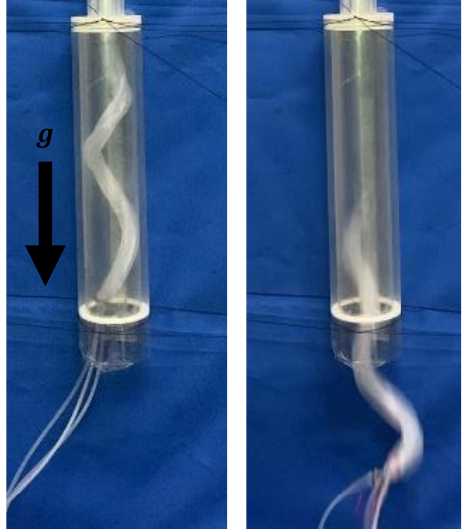
Figure 17. Experiment using a biased pitch device, driven by an air pressure of 0.14 MPa into a vertically fixed pipe with the same diameter as that of the 40A and the